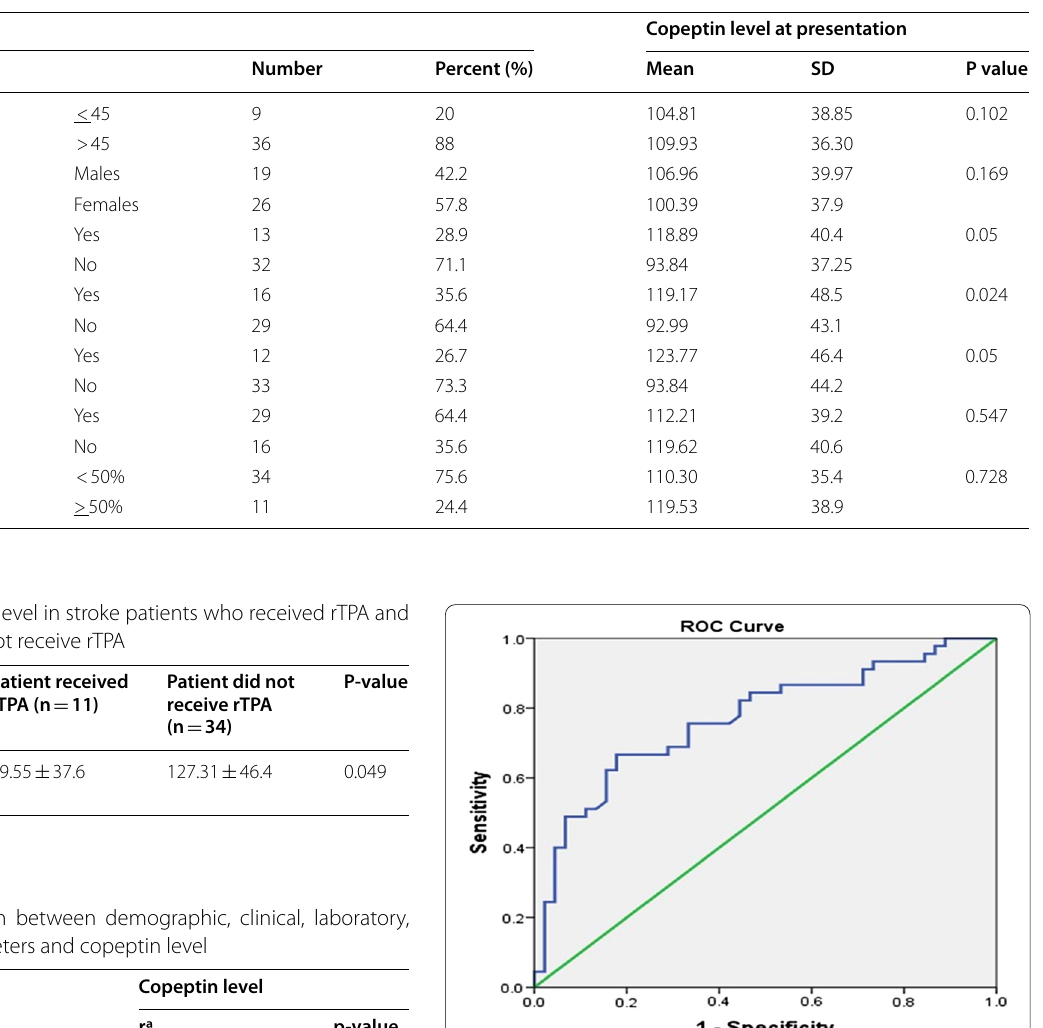
Fig. 1 ROC curve analysis to assess the prognostic role of copeptin level after acute ischemic